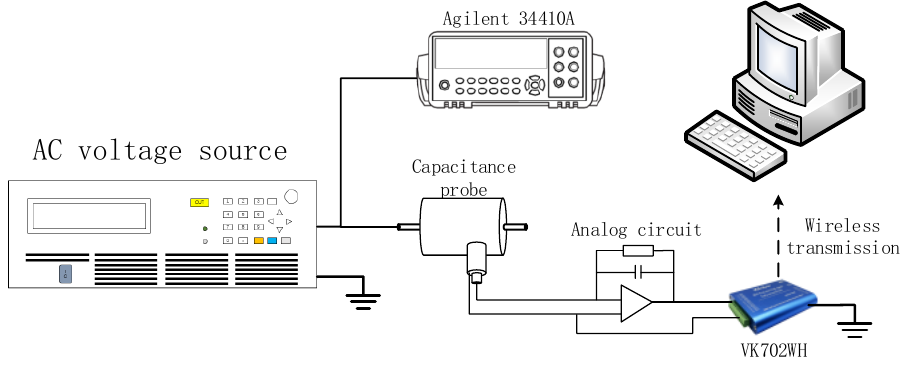
Figure 10. Noncontact AC voltage measurement test platform.